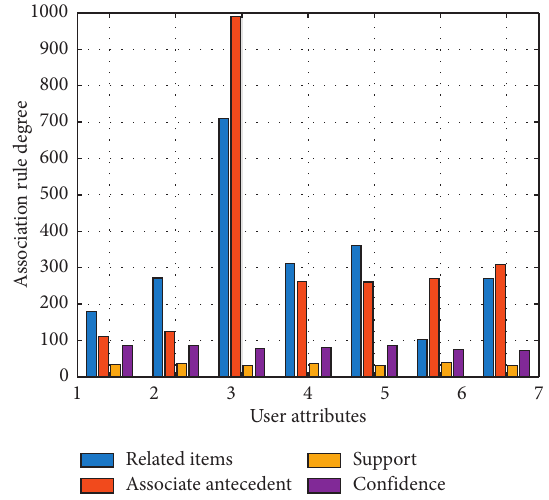
Figure 8: Strong association rules after